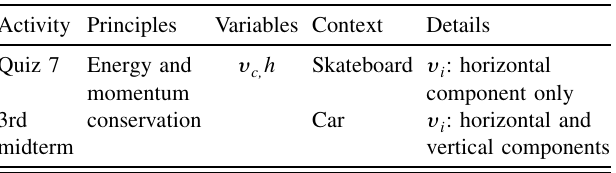
TABLE III. Comparison of pre (quiz 7) and post (3rd midterm)